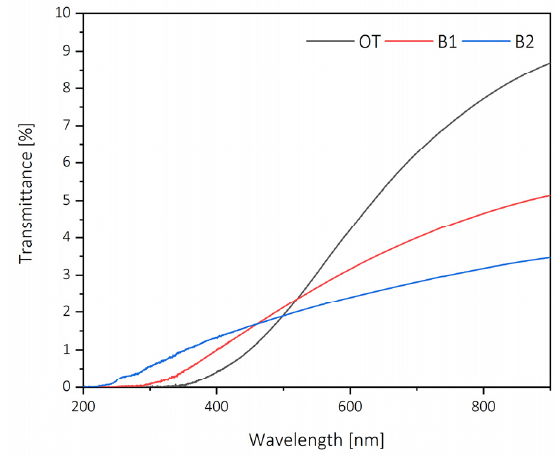
Figure 8. UV–vis spectra of the elaborated films.